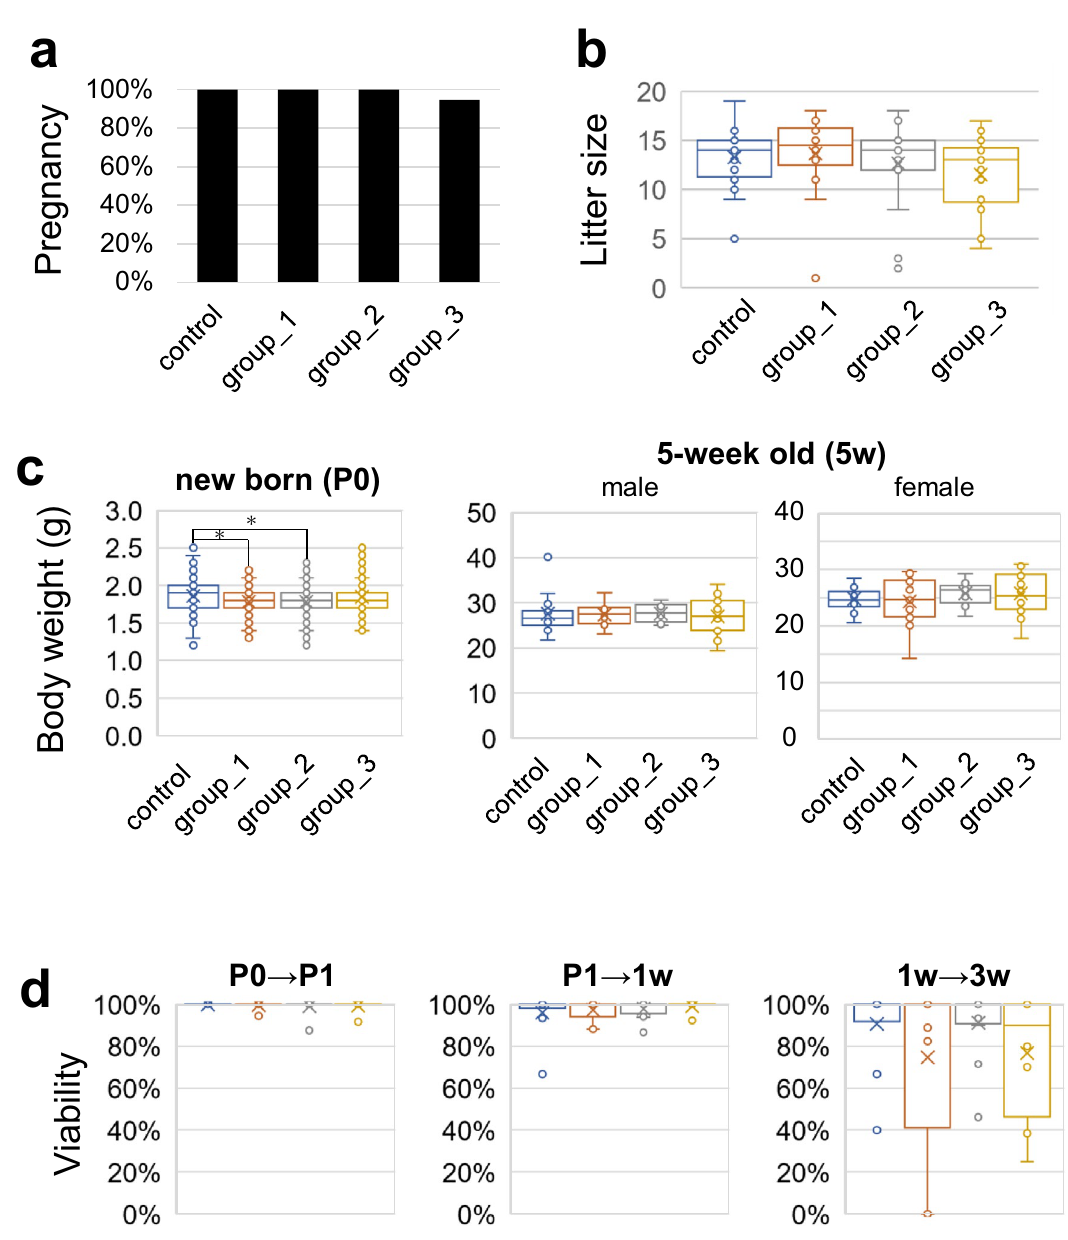
Figure 3. Effects on pregnancy and offspring’s development in the LHRHa-treated female. Data were used for all plug-positive female mice after mating with wild-type ICR male mice in Fig. 2, Table 2, Table 3 and Supplementary Table S3. Control in Fig. 3 means LHRHa non-treated plug positive female mice results. ( a ) Rate of delivered female mice in plug-positive females. ( b ) Litter sizes in each pregnant female mouse group. ( c ) Body weight (g) of offspring from each pregnant female mouse group at E19.5 (P0) and 5-week old. ( d ) Offspring viability 1 day after birth (P0 → P1), from P1 to 1-week old (P1 → 1w), and from 1-week old to